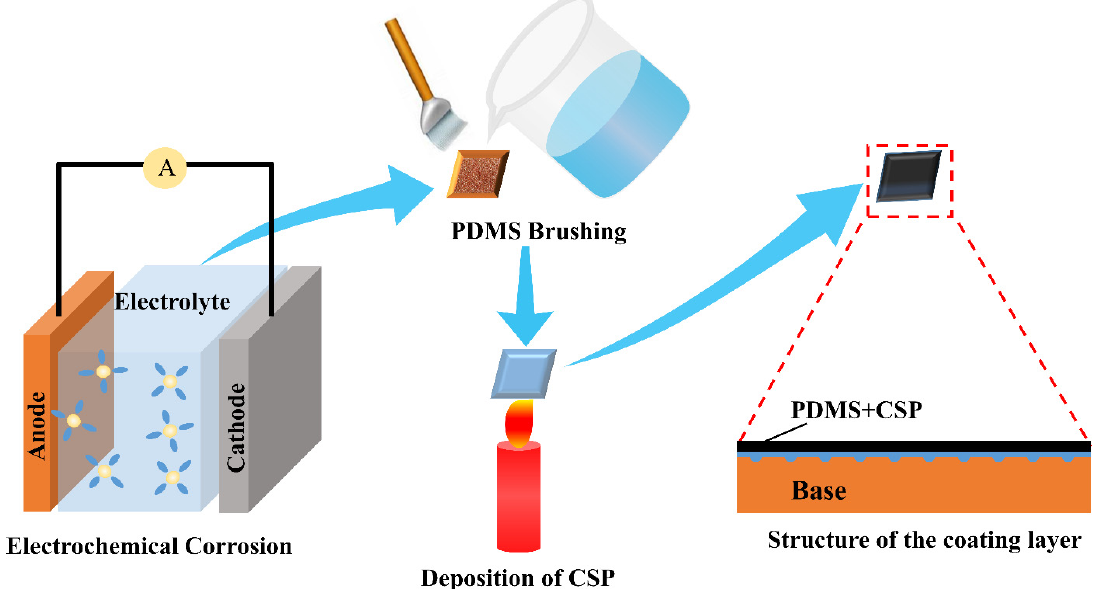
Figure 1. Schematic diagram of the preparation process of superhydrophobic coating samples.